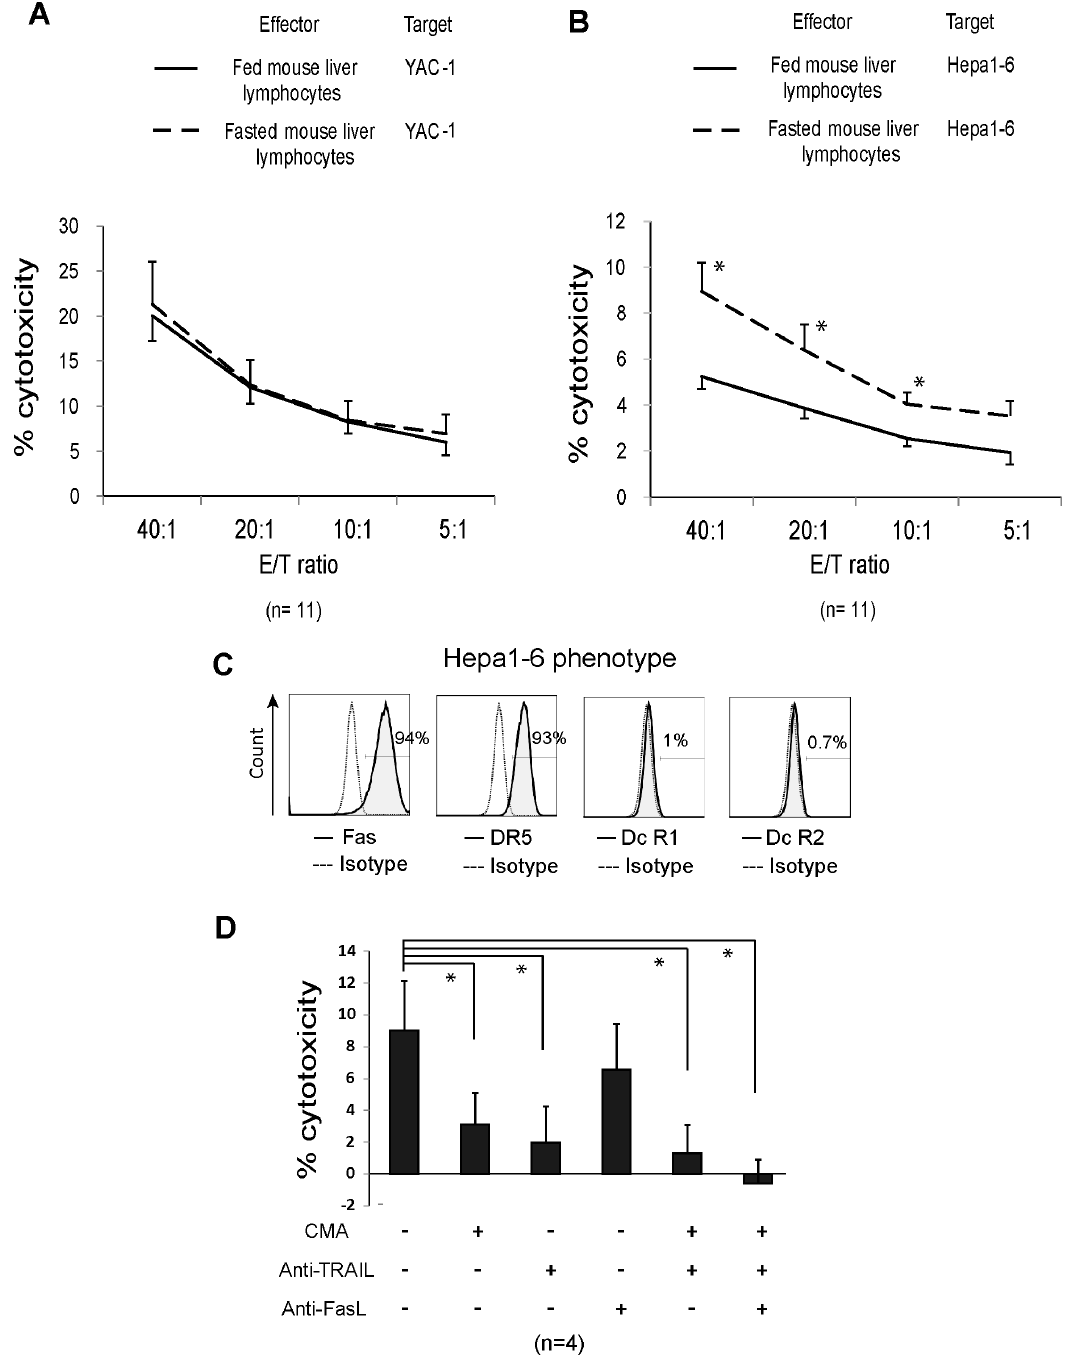
Figure 5. Assay analyzing cytotoxic effects of liver lymphocytes obtained from fasted mice on tumor cells. (A) The cytotoxic activity of freshly isolated liver lymphocytes from fed mice (solid lines) and 3-day-fasted mice (dashed lines) against TRAIL-resistant YAC-1 and (B) TRAIL- sensitive Hepa1-6 cells was analyzed using the 51 Cr-release assay. The effector to target (E/T) ratios were 40:1, 20:1, 10:1, and 5:1. The cytotoxicity percentage was calculated as the percentage of specific 51 Cr release, as described in the materials and methods section. Data are presented as mean 6 standard error of the mean from triplicate samples of 11 repeated assays, each including 1 fed and 1 fasted mouse. (C) Histograms show the phenotype of Hepa1-6 cells that was analyzed using antibodies against mouse Fas, death receptor 5 (DR5), and decoy TRAIL receptor 1 and 2 (DcR1 and DcR2) in solid lines. Negative controls, which were stained with isotype-math antibodies, are indicated using dotted lines. The proportion of Hepa1-6 cells positive for those markers is provided. (D) Liver lymphocytes that were obtained from 3-day-fasted mice were incubated with CMA, anti-TRAIL mAb, anti-FasL mAb, or their combination before incubation with 51 Cr-labeled-Hepa1-6 for 4 hours, at a lymphocyte: Hepa1-6 ratio of 40:1. Bar graph shows the mean cytotoxicity percentage plus standard deviation for each group. Statistical analysis was performed for each ratio using the independent samples T test; * p , 0.05.